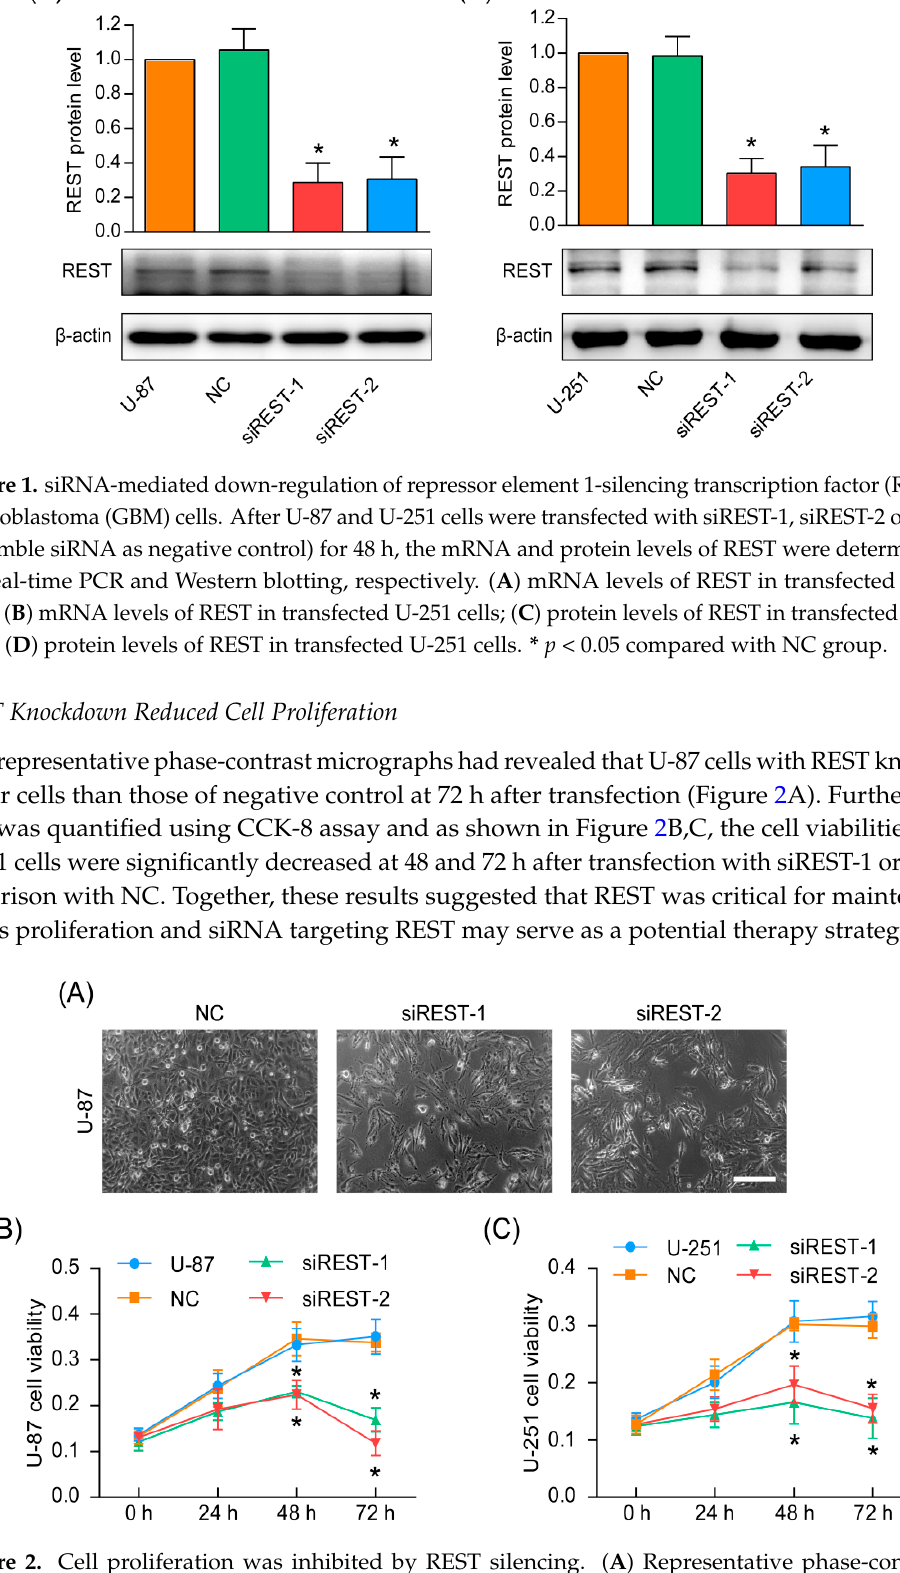
Figure 2. Cell proliferation was inhibited by REST silencing. ( A ) Representative phase-contrast micrographs of transfected U-87 cells; ( B ) cell viability of transfected U-87 cells; ( C ) cell viability of transfected U-251 cells. * p < 0.05 compared with NC group. Scale bar indicates 200 nm.